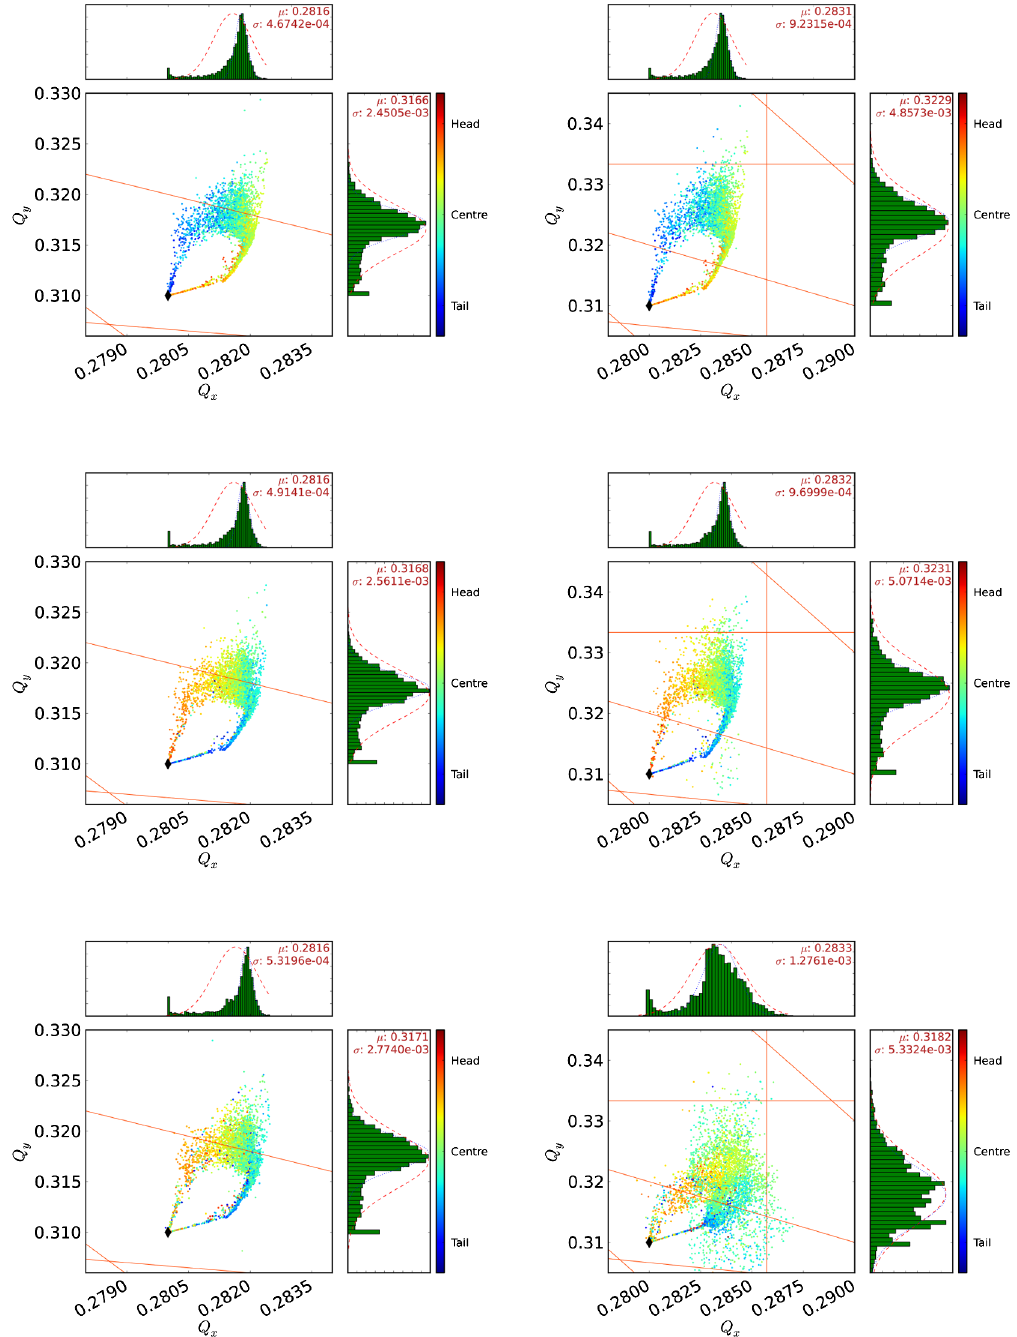
FIG. 20. Tune footprint snapshots in a bending magnet at 450 GeV after 1 = 6 (top), 1 = 2 (middle), and 3 = 2 (bottom) synchrotron periods. Left: Below the instability threshold ( (cid:6) c ¼ 4 : 3 (cid:2) 10 11 m (cid:1) 3 , n b ¼ 1 : 15 (cid:2) 10 11 ppb ). Right: Above the intensity threshold ( (cid:6) c ¼ 8 : 5 (cid:2) 10 11 m (cid:1) 3 , n b ¼ 1 : 15 (cid:2) 10 11 ppb ). Resonance lines up to 11th order have been